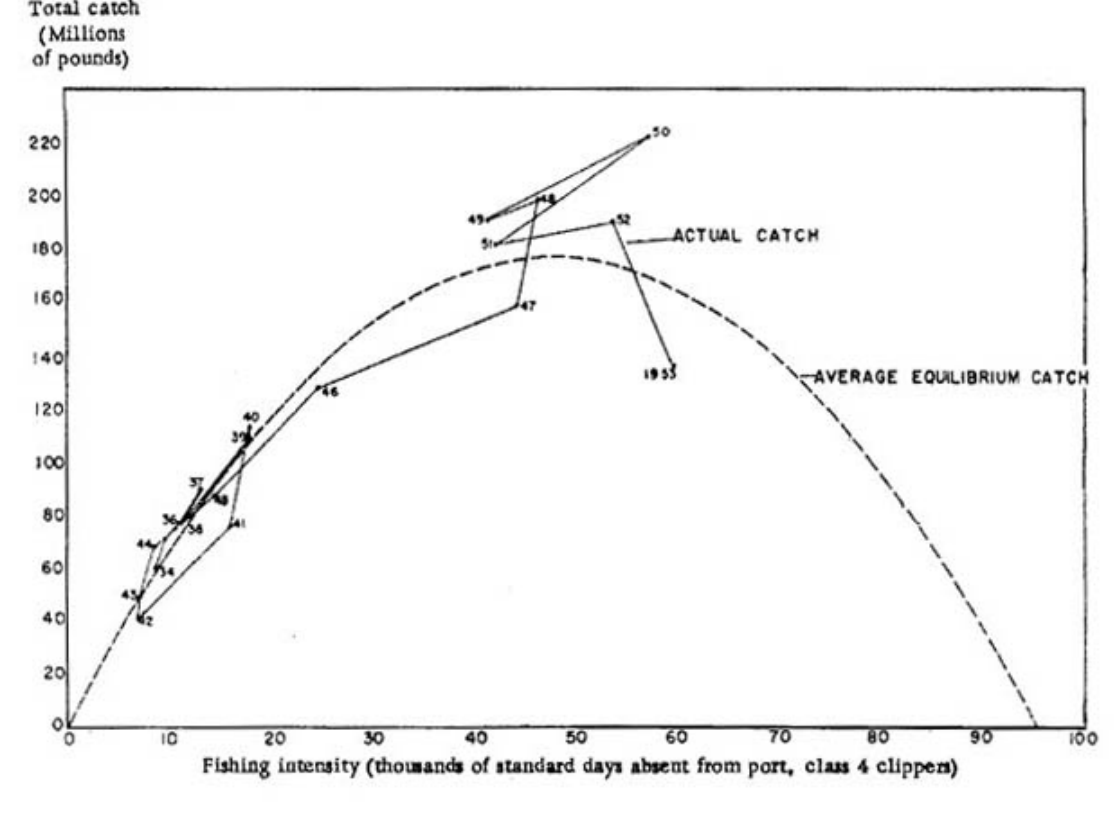
Fig. 2. Schaefer’s curve showing yellowfin tuna populations and the catch from 1934–1953 (Source: Schaefer